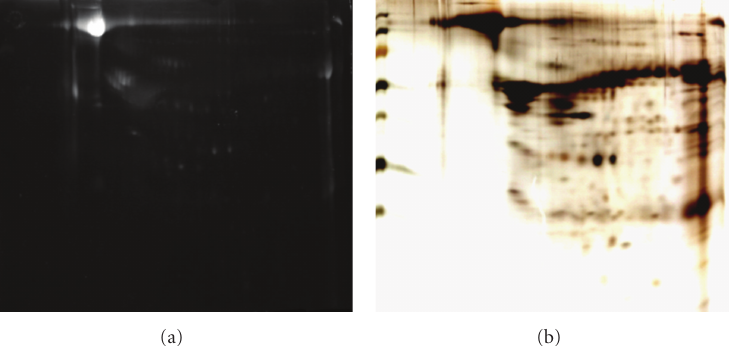
Figure 6: (a) LRSH staining of prefractionated pregnancy urine in 2-DE. (b) Silver staining of the same gel. A total of 10mL of pregnancy urine was utilized for prefractionation and 2-DE